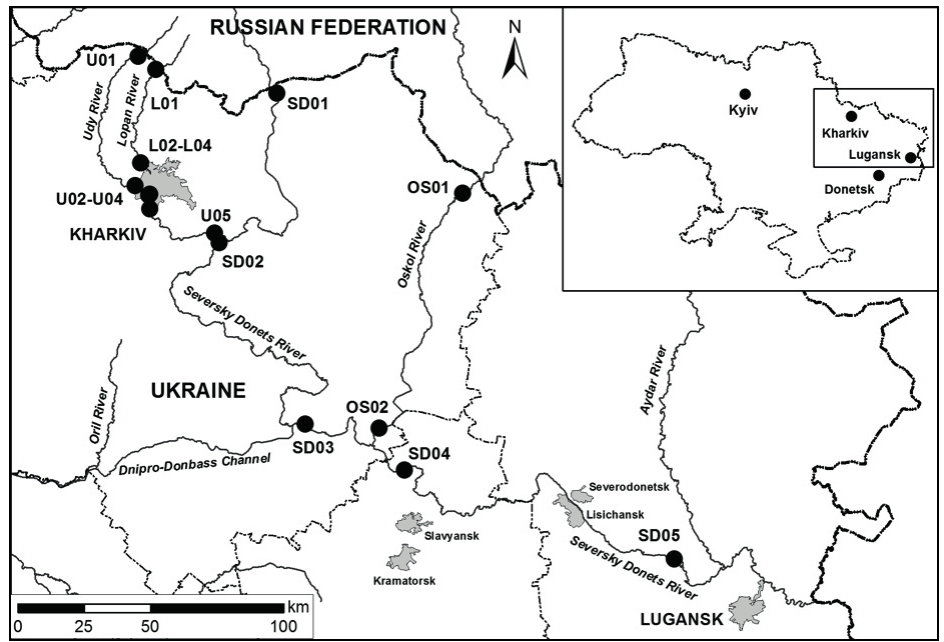
Fig. 1 The location of the Seversky Donets watershed and sampling